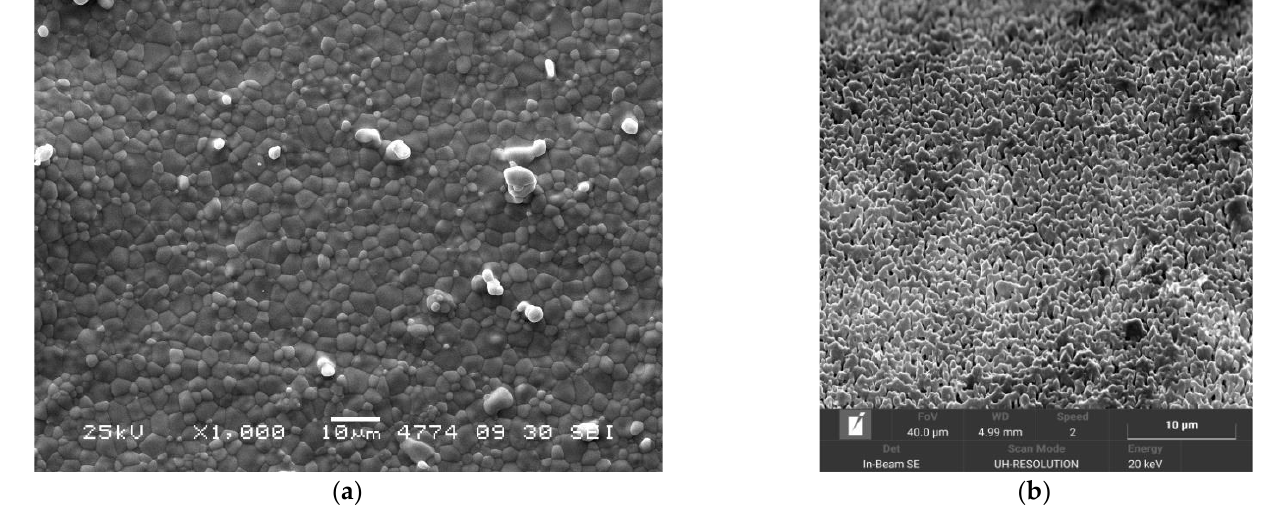
Figure 2. SEM images of ( a ) LCNb and ( b ) LCNbTi after calcination at 1100 ◦ C. Figure 2 shows the SEM images of LCNb and LCNbTi powders sintered at 1100 ◦ C for 4 h. The La 0.99 Ca 0.01 NbO 4 sample is quite dense and pore-free, with similar grain sizes in the range of 2–6 µ m (Figure 2a). Titanium-doped lanthanum orthoniobate is still very porous after 4 h of sintering, with a grain size distribution varying from 1 to 4 µ m (Figure 2b).